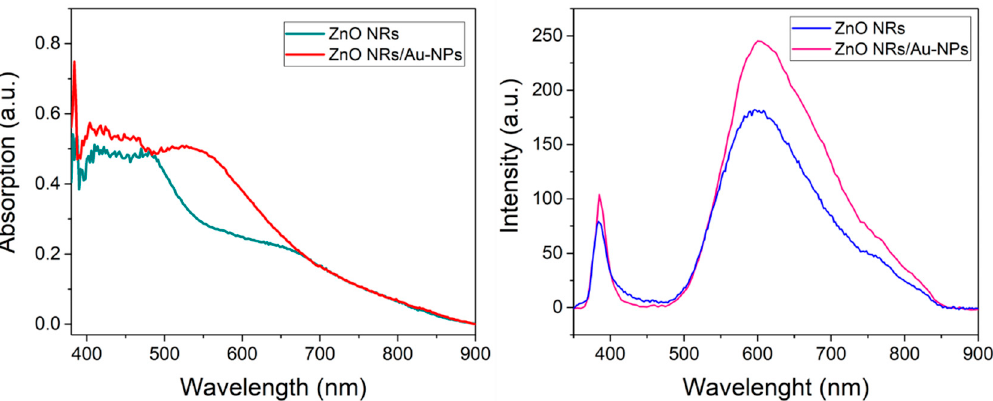
Figure 5. ( a ) Optical absorption ultraviolet-visible light diffuse reflectance spectra (UV-vis DRS) confirming the enhancement of absorption spectra in the range of 500–600 nm. ( b ) Photoluminescence (PL) spectra of the bare ZnO NRs and ZnO NRs/Au NPs at deep level (DL) emission spectra.